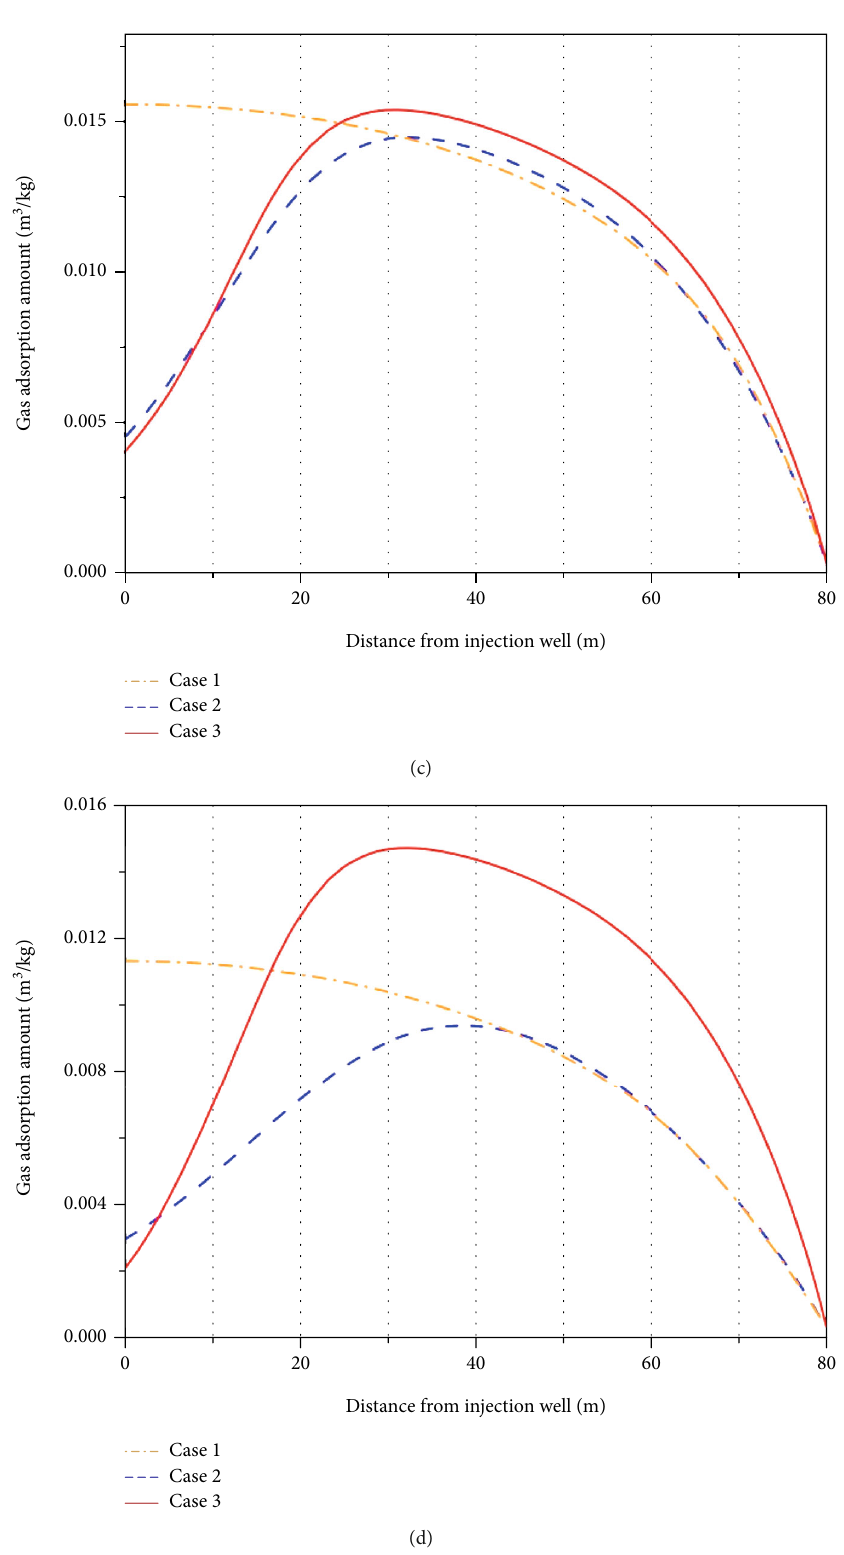
Figure 13: The spatial distribution of gas adsorption amount for three di ff erent cases at monitoring line after (a) one-year, (b) four-year, (c) ten-year, and (d) twenty-year